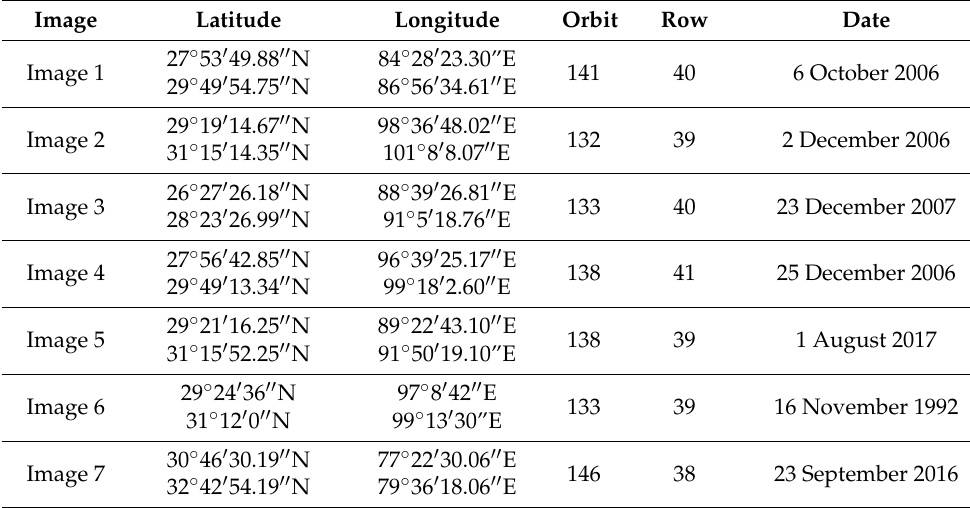
Table 1. The parameters of the 7 TM